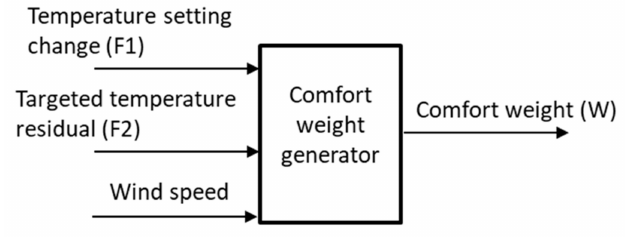
Figure 1. Framework of system for deriving comfort